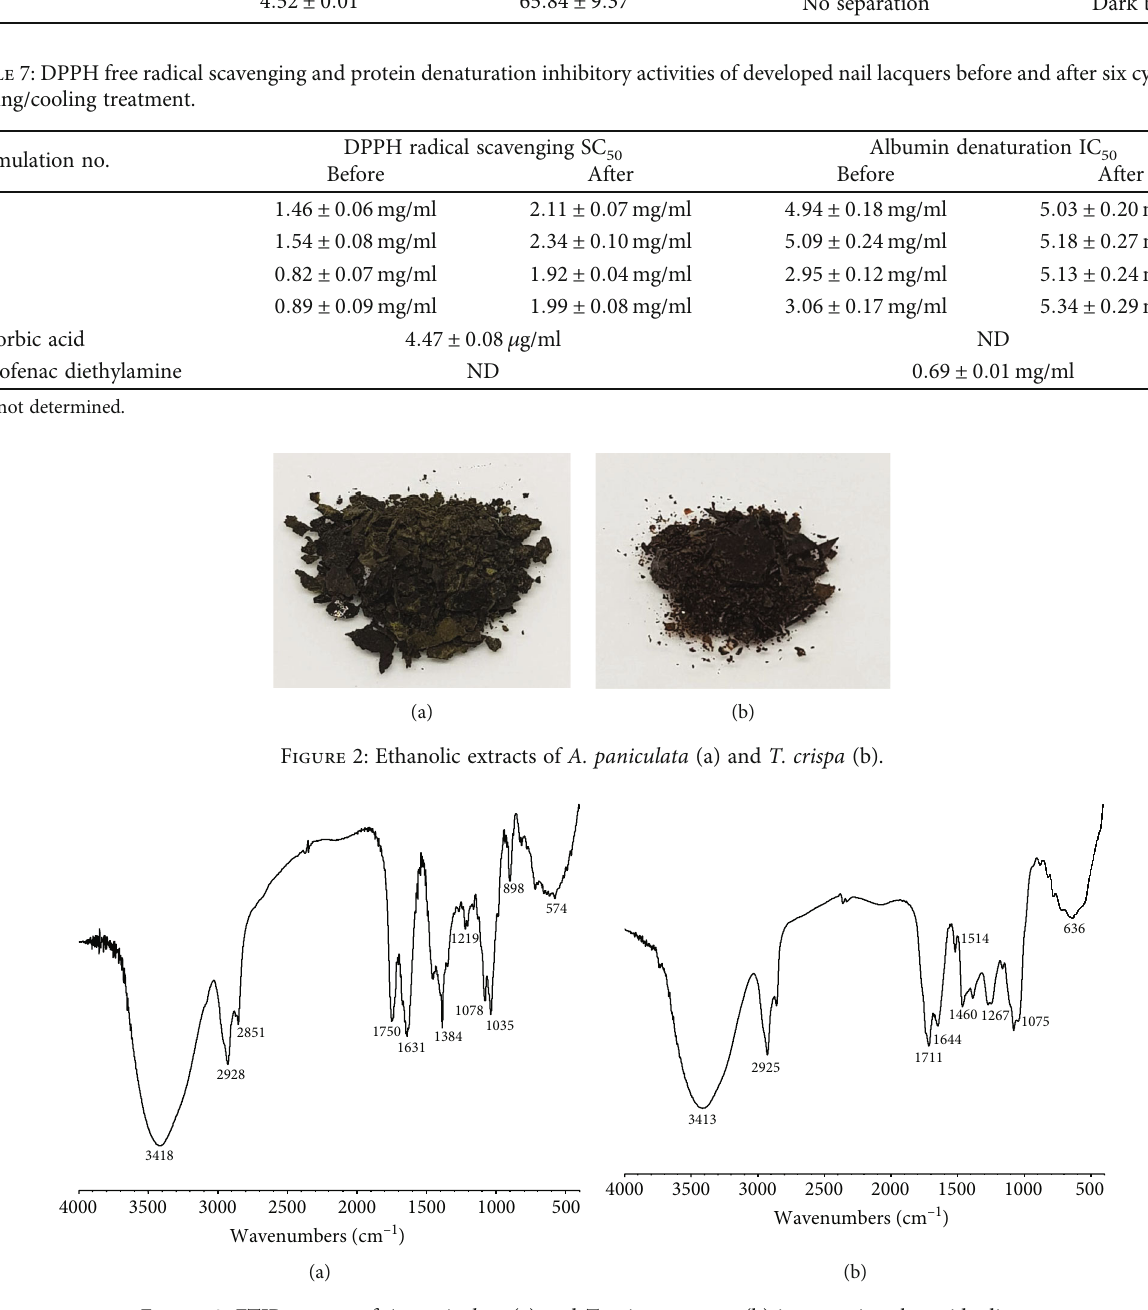
Figure 3: FTIR spectra of A. paniculata (a) and T. crispa extracts (b) in potassium bromide